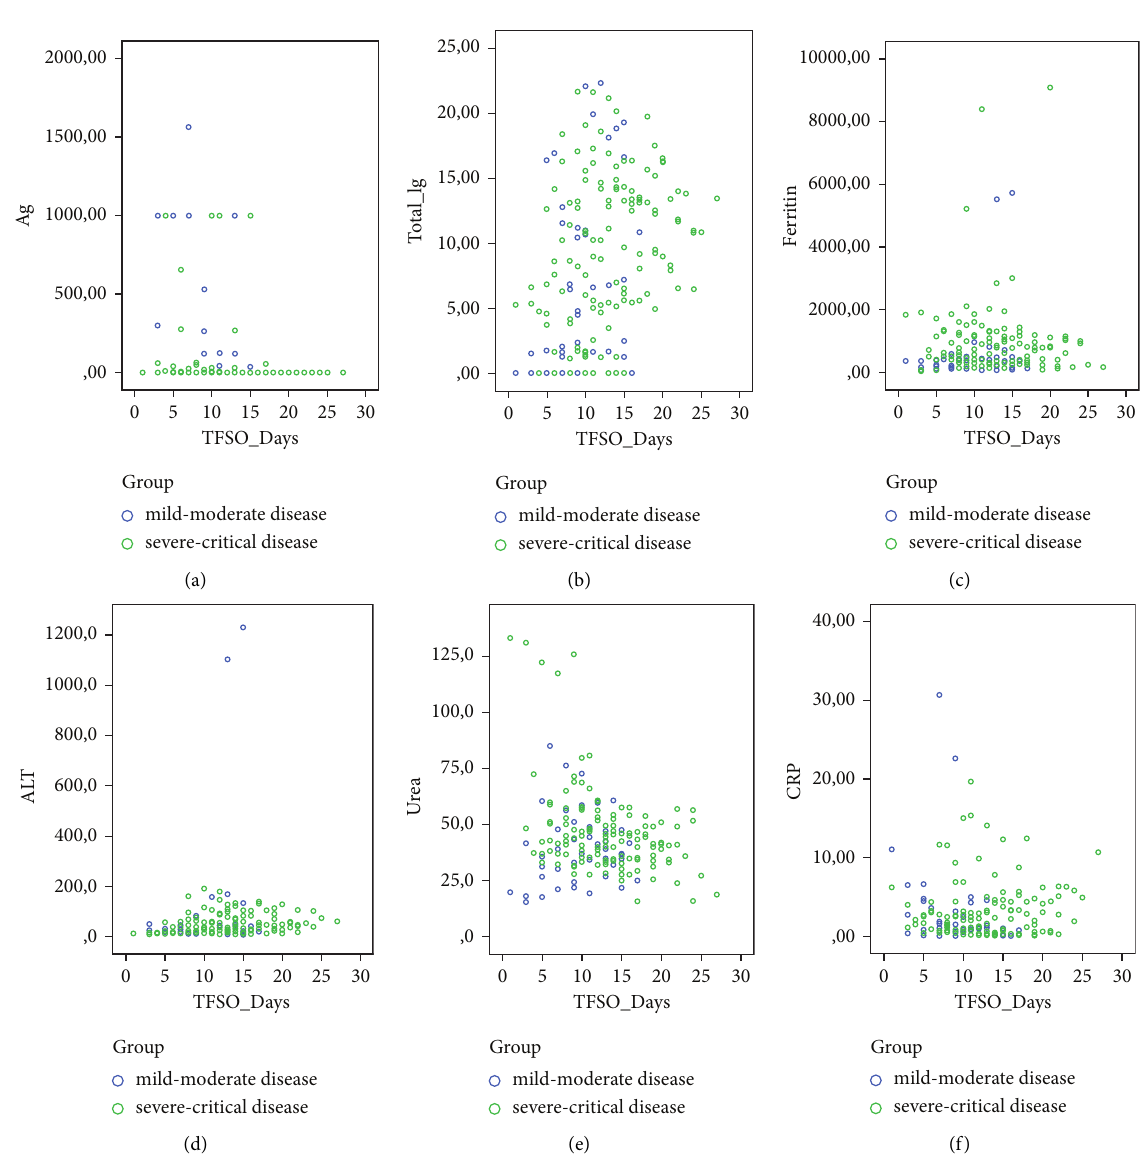
Figure 3: Values of the SARS-CoV-2 Ag (a), total Ig (b), ferritin (c), ALT (d), urea (e), and CRP (f) variables over time, in mild-moderate and severe-critical cases. TFSO :time from symptom onset